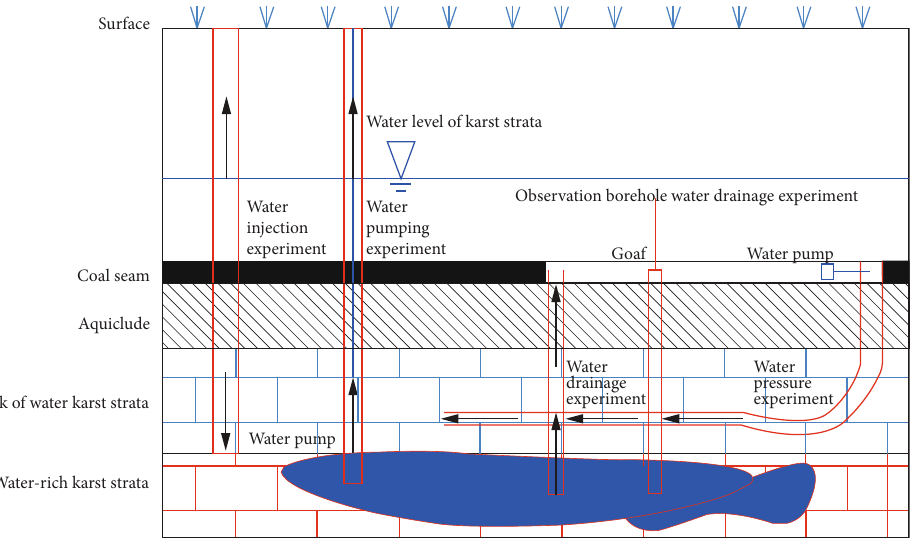
Figure 4: Schematic diagram of four kinds of hydrological in situ